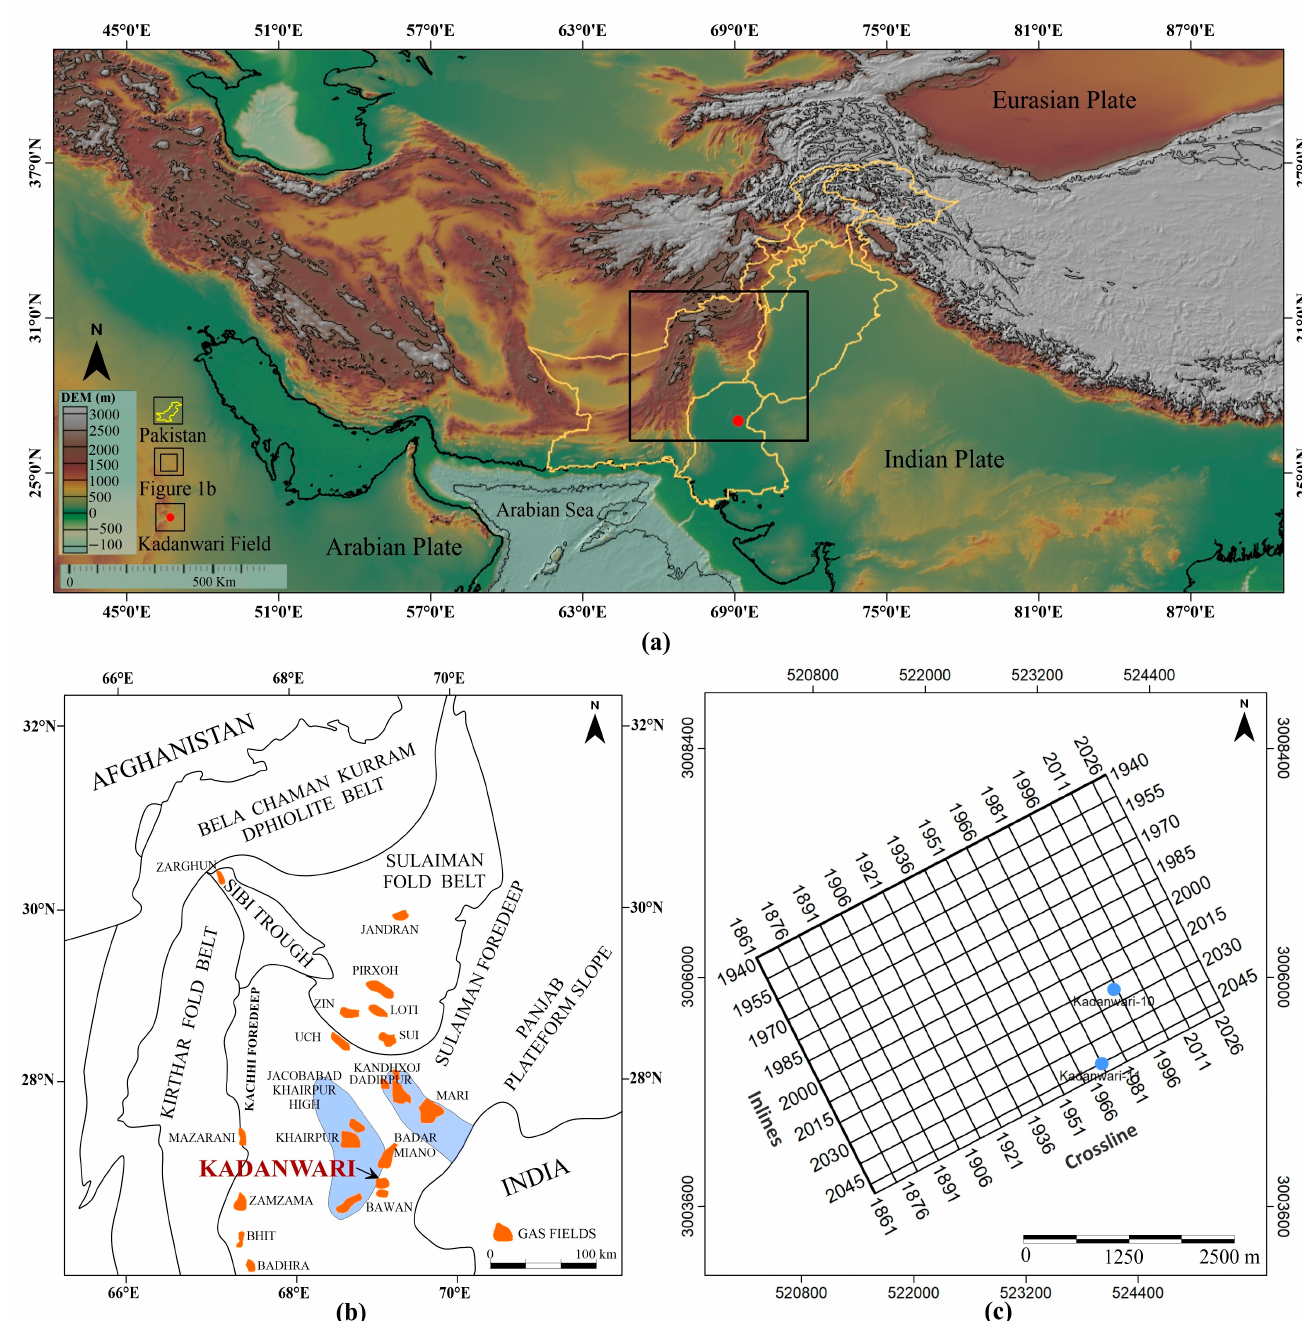
Figure 1. ( a ) Location of the study area; ( b ) generalized tectonic map with the location of major oil- and gas-producing fields in the study area, bounded by other gas fields, modified from [49]; ( c ) the base map shows the orientation and general information of the 3D seismic lines and wells in the Kadanwari field, MIB, Pakistan.